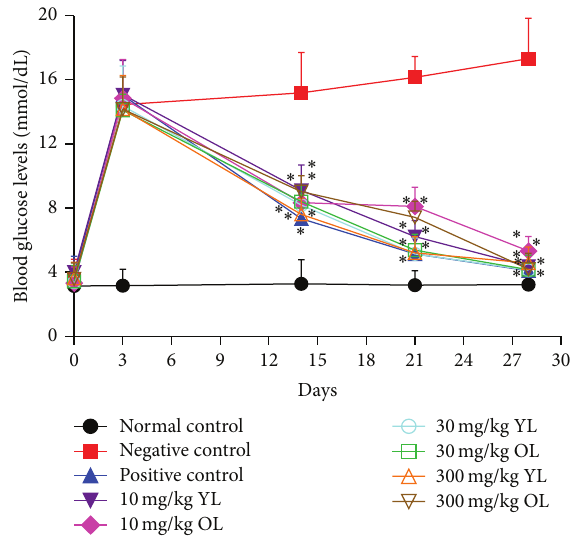
Figure 1: Blood glucose levels before and after administration of both old and young leaf extracts of V. amygdalina. Values are expressed as mean ± SEM ( 𝑛 = 7 ). Note: 𝑝 < 0.05 was considered statistically significant. ( ∗ ) = statistical difference between treated groups and negative